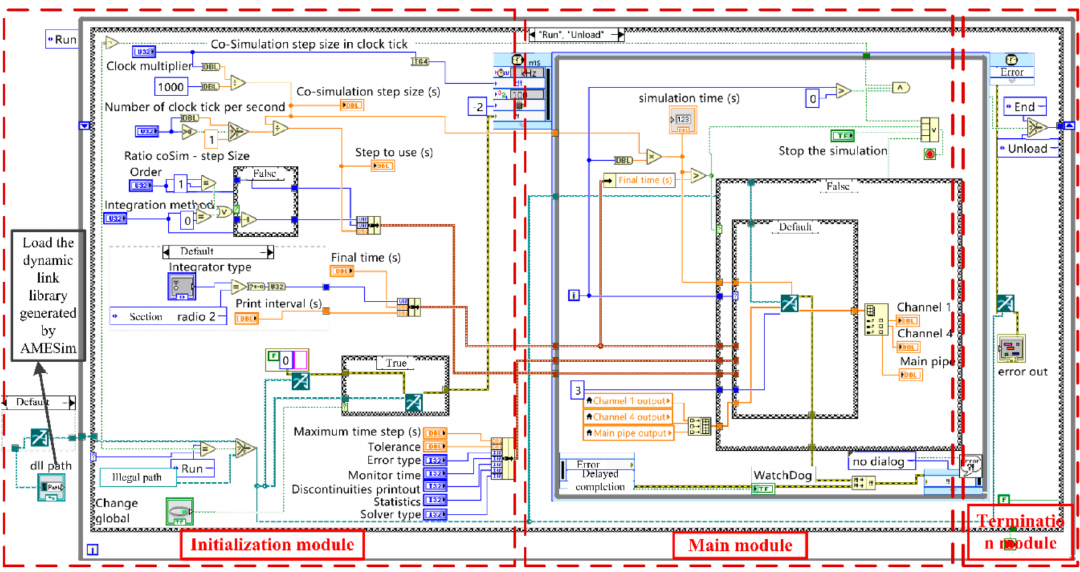
Figure 8. Co-simulation interactive console program